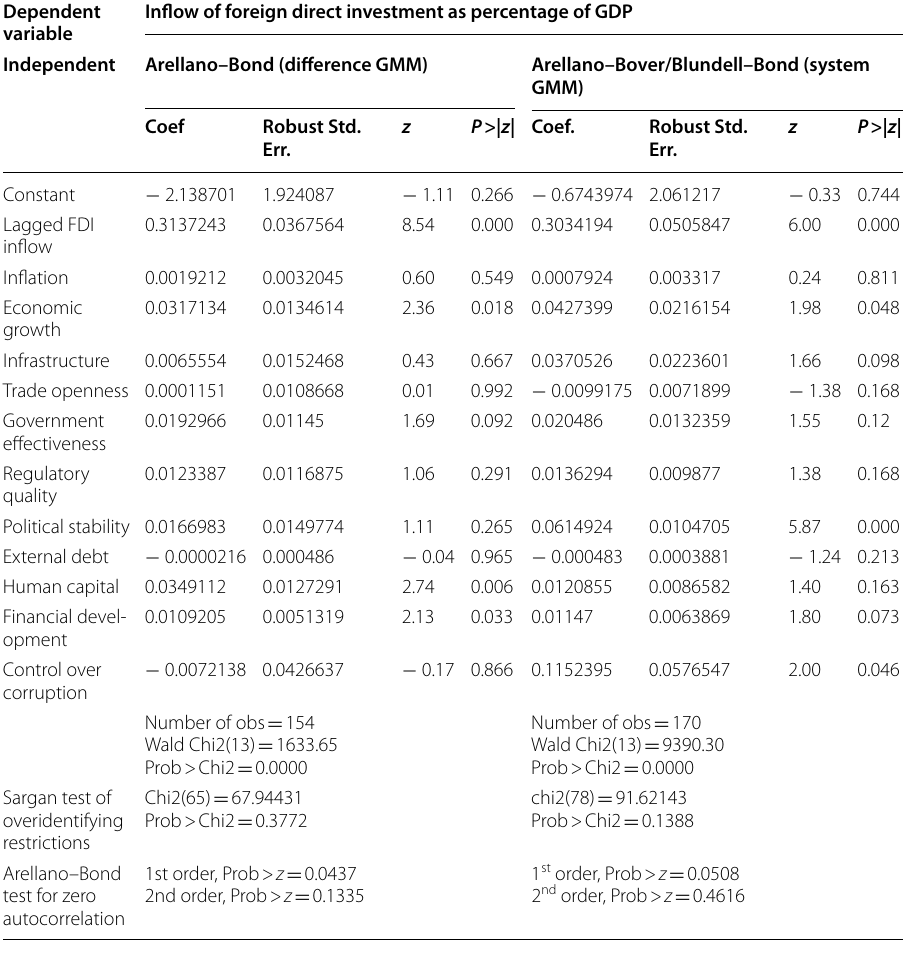
Table 3 Statistical result of dynamic panel